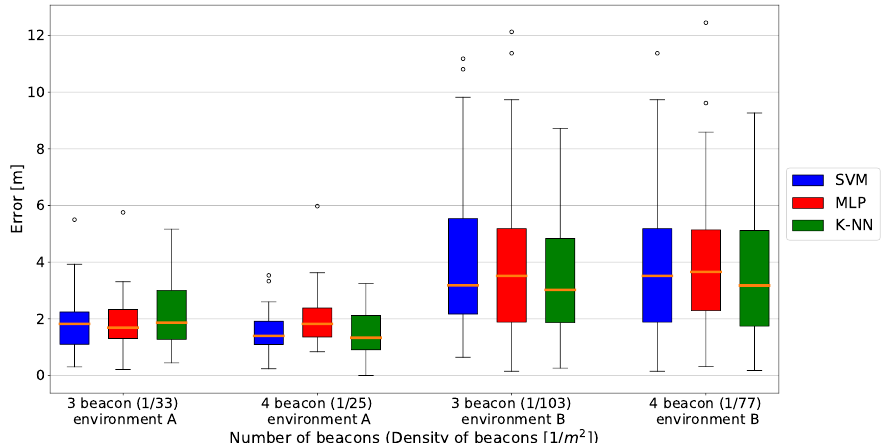
Figure 7. Error box plots for the three fingerprinting algorithms with different beacon densities. Results for a fingerprint grid with one measurement every 0.5